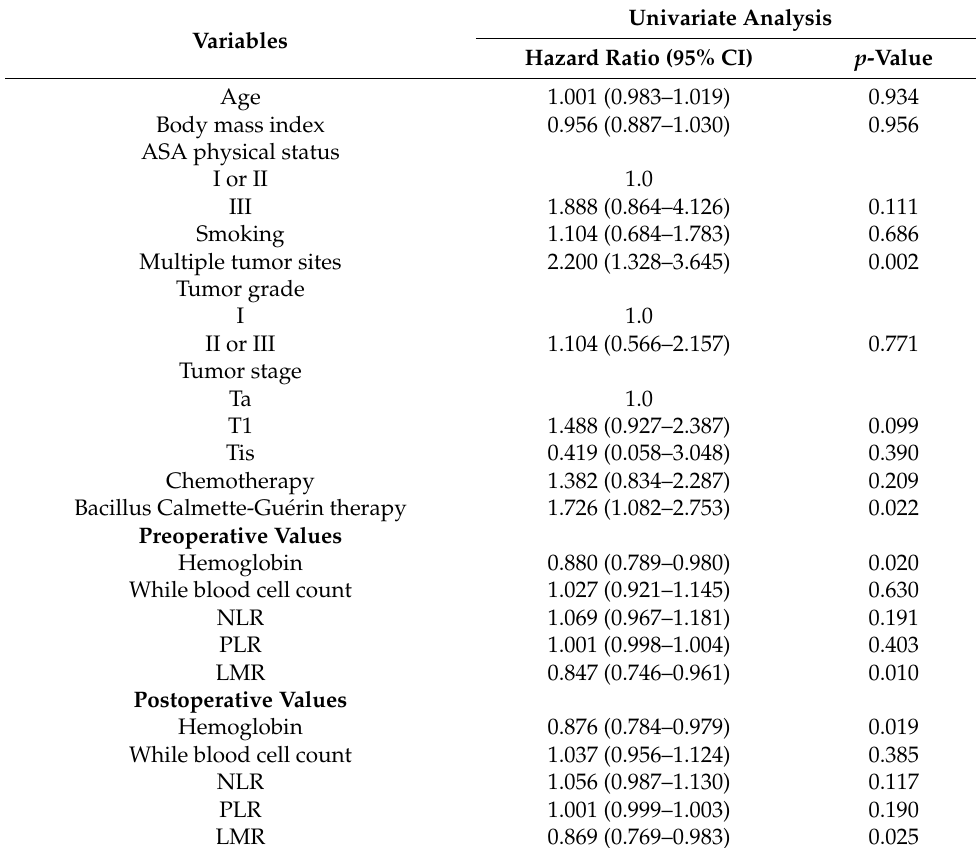
Table 3. Univariate Cox regression analysis for five-year bladder tumor recurrence.